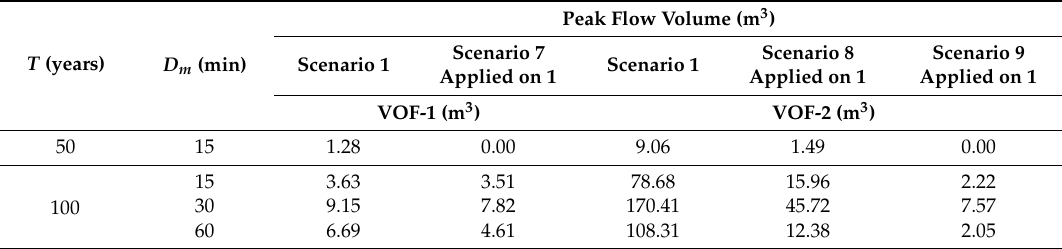
Table 9. Peak flow volumes based on the Scenario 1.